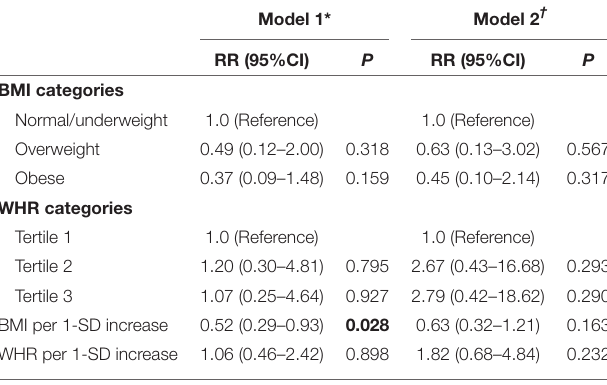
TABLE 4 | Associations between BMI and WHR with the presence of DR